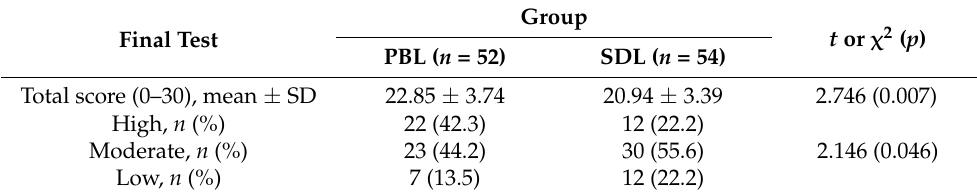
Table 4. Differences in the PBL and SDL groups’ final test